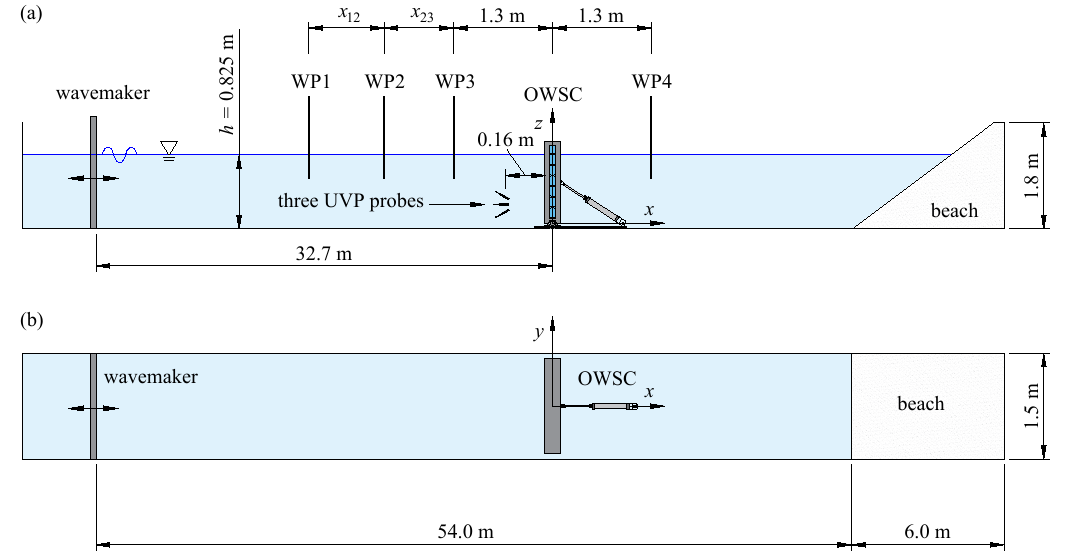
Figure 1. Schematic sketch of the wave flume arrangement: ( a ) side view; ( b ) plan view. The coordinates x , y , and z refer to the longitudinal (wave direction), lateral and vertical directions, respectively, for which x = 0 at 32.7 m from the wavemaker; y = 0 at center plane of the flume; and z = 0 at 0.1 m from the flume bed in the pivot point of the flap (see Figures 2 and